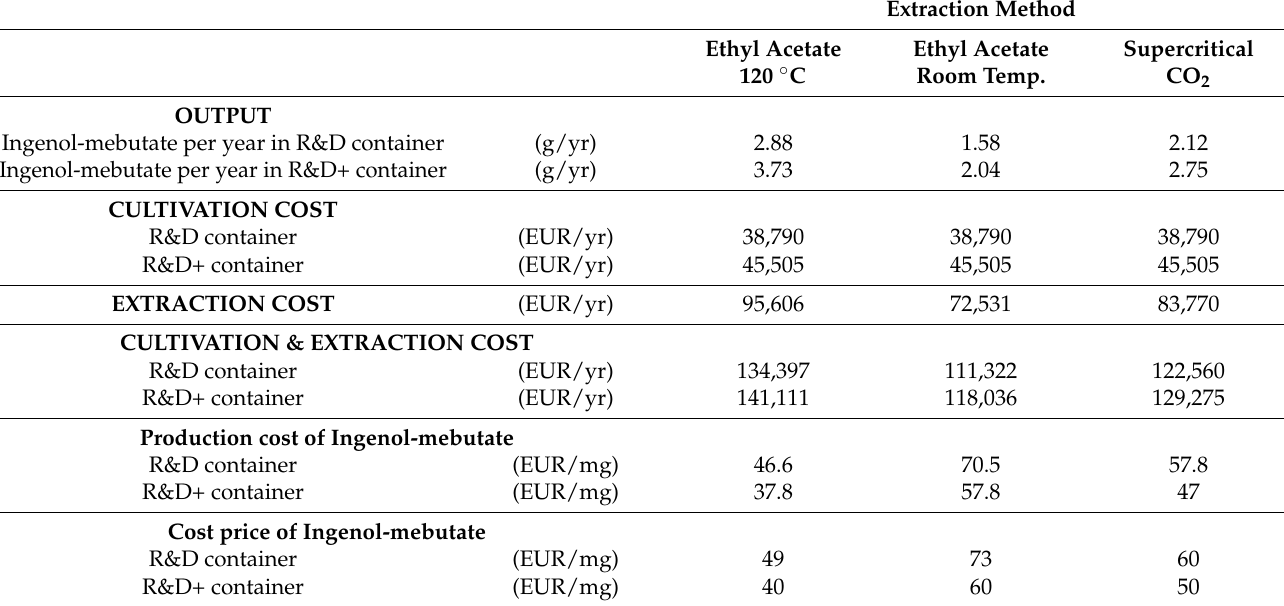
Table 6. Production cost and cost price of ingenol-mebutate extracted from vertically cultivated E. peplus according to three methods (ethyl acetate at 120 ◦ C, ethyl acetate at room temperature and supercritical CO2), calculated from the cultivation cost and extraction cost, and according the biomass generated in the “R&D” and “R&D+” containers with luminosity of 500 PAR. Cost price are production cost plus flat fees.